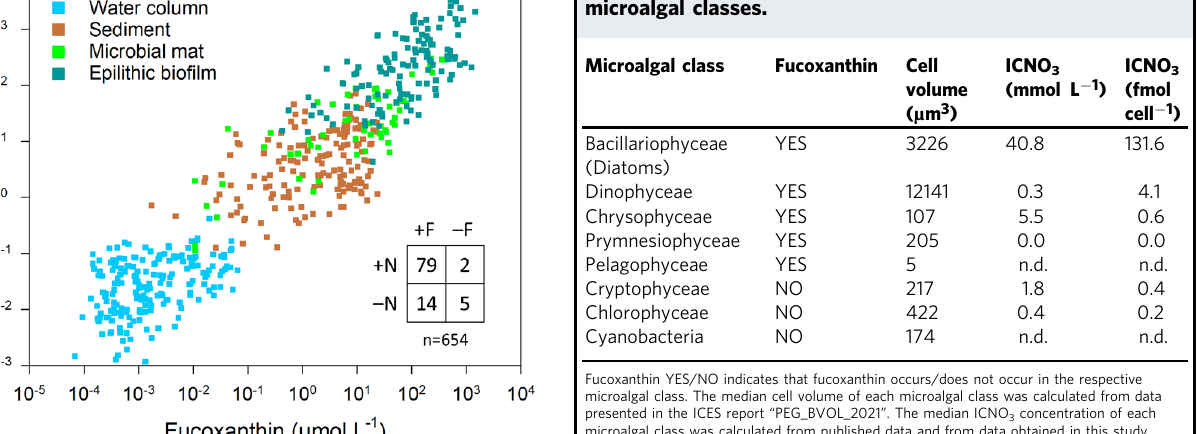
Table 1 Intracellular nitrate storage capacity by different microalgal